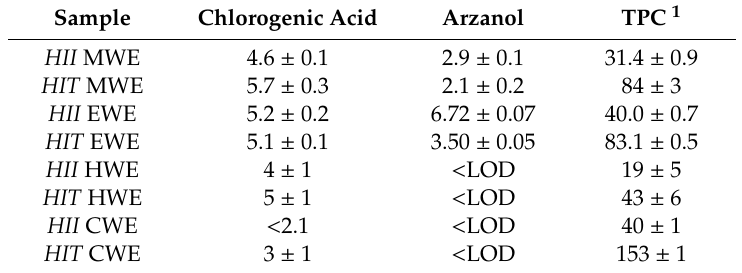
Table 1. Quantification of two most characteristic compounds (mg / g dried material) and the